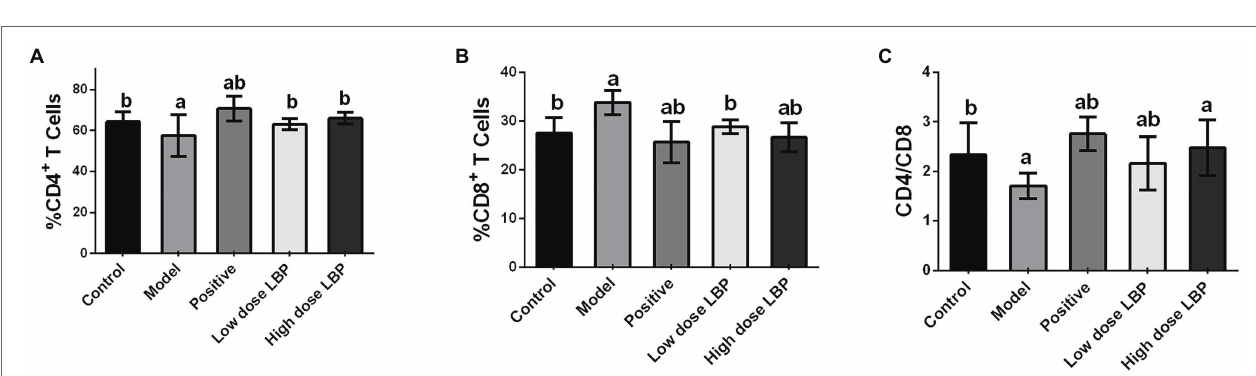
FIGURE 4 | Splenic CD4+ and CD8+ T cell rates in immunosuppressed mice. (A–C) Statistical analysis of the percentages of CD4+ and CD8+ T cells and CD4+/ CD8+ ratios. Data are mean ± SD ( n = 8). a p < 0.05 vs. control group; b p < 0.05 vs. model